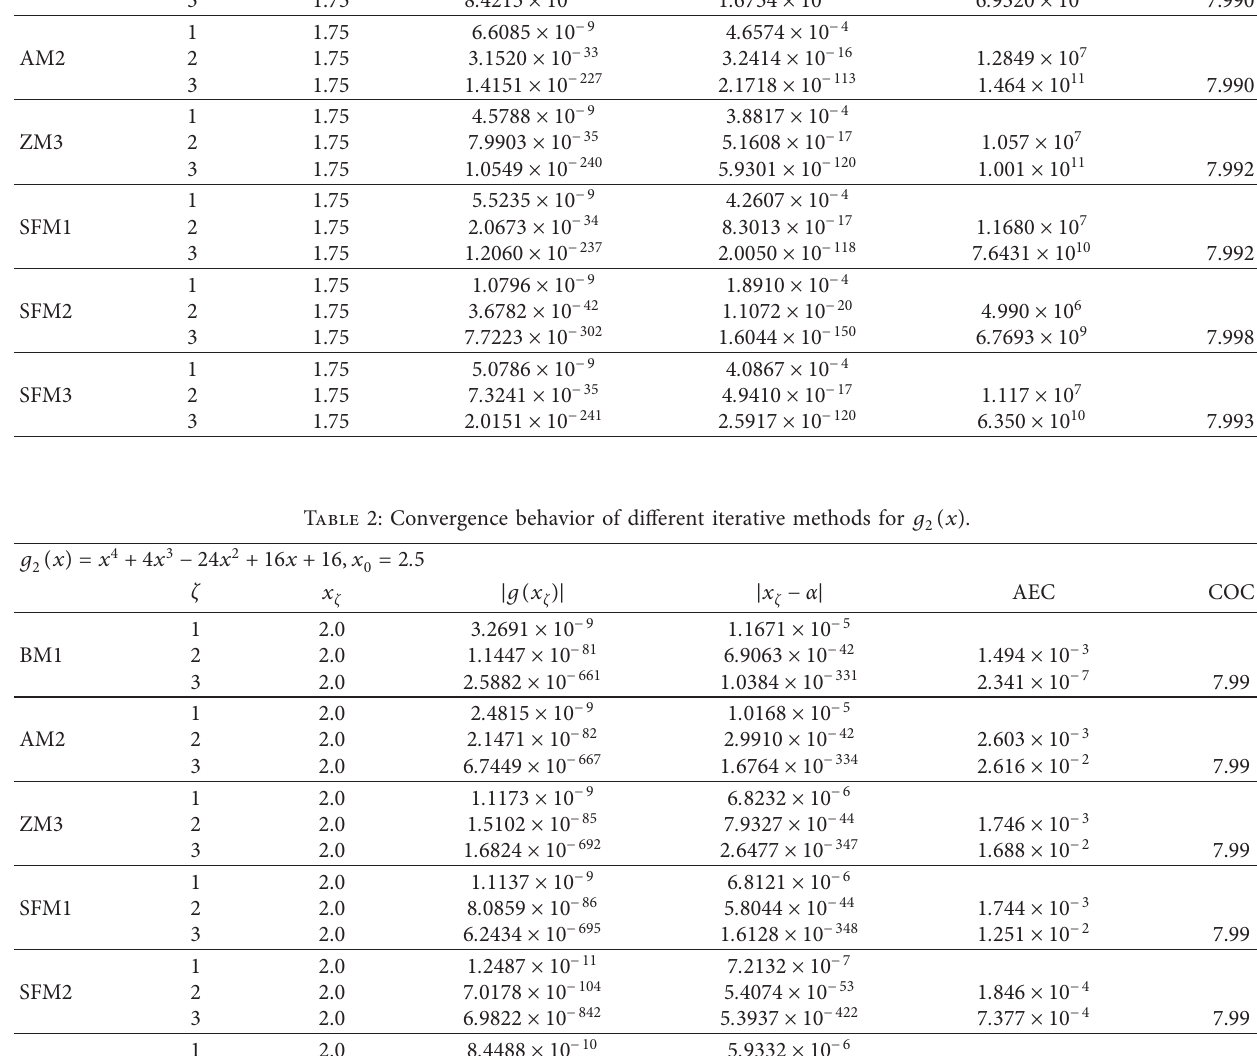
Table 1: Convergence behavior of different iterative methods for g